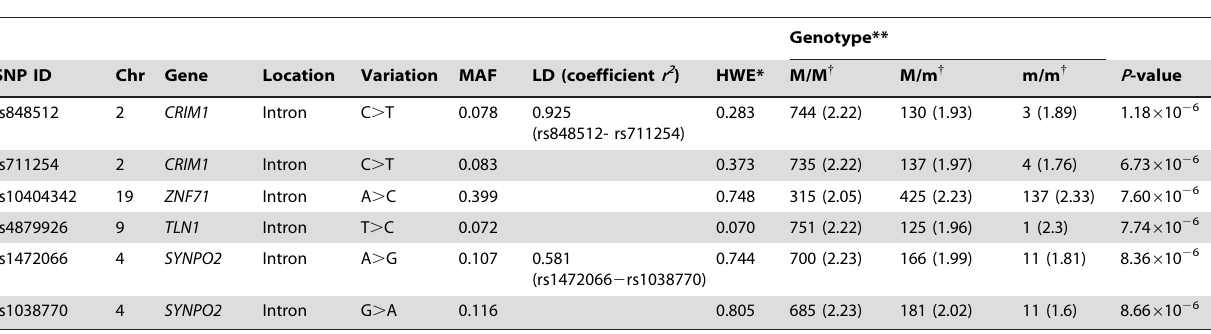
Table 2. Top 6 SNPs ( P , 1.0 6 10 2 5 ) associated with total IgE of asthmatics in the